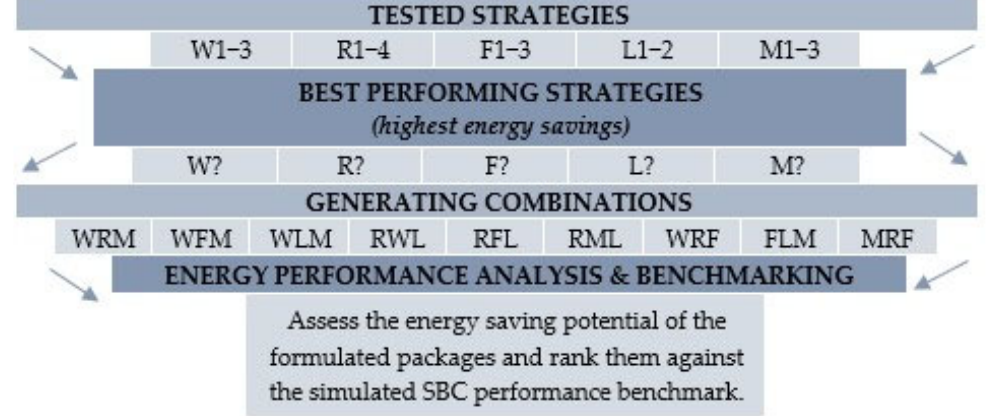
Figure 5. The design process for formulating the favoured retrofitting packages for a tailored programme. Table 6. Selected strategies for simulation testing.